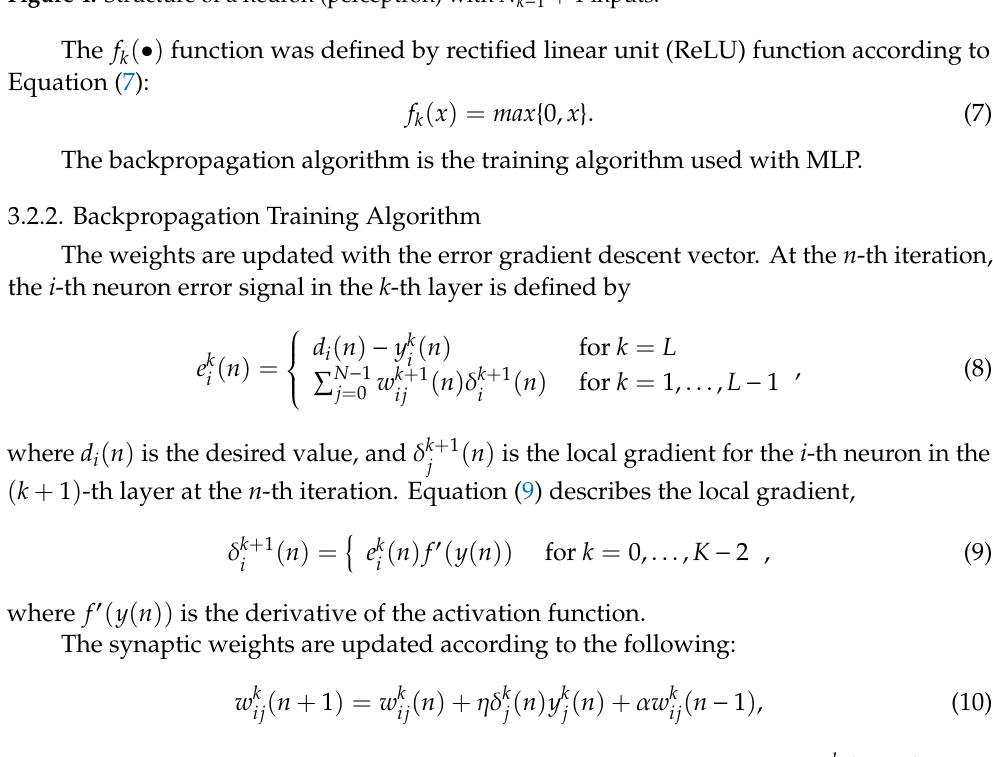
Figure 4. Structure of a neuron (perceptron) with N k − 1 + 1